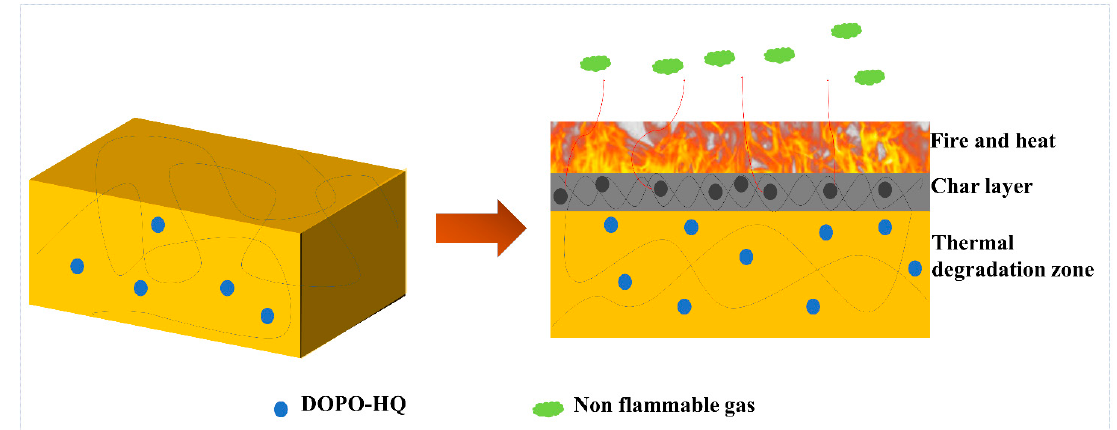
Figure 14. Possible flame-retardant mechanism.